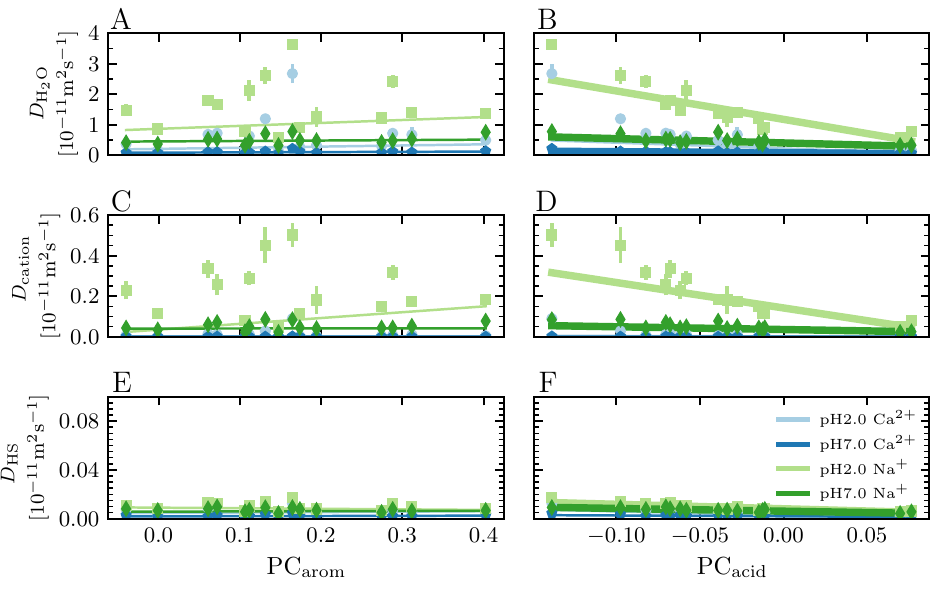
Figure 5. Diffusion of the standard humic substances models as a function of their PC arom and PC acid . Plots show the diffusion of water molecules ( A , B ), cations ( C , D ) and humic substances ( E , F ) in function of their PC arom and PC acid . Each point represents the average over four independent simulations with error bars representing the standard error. Notice the different y -axis scales in these